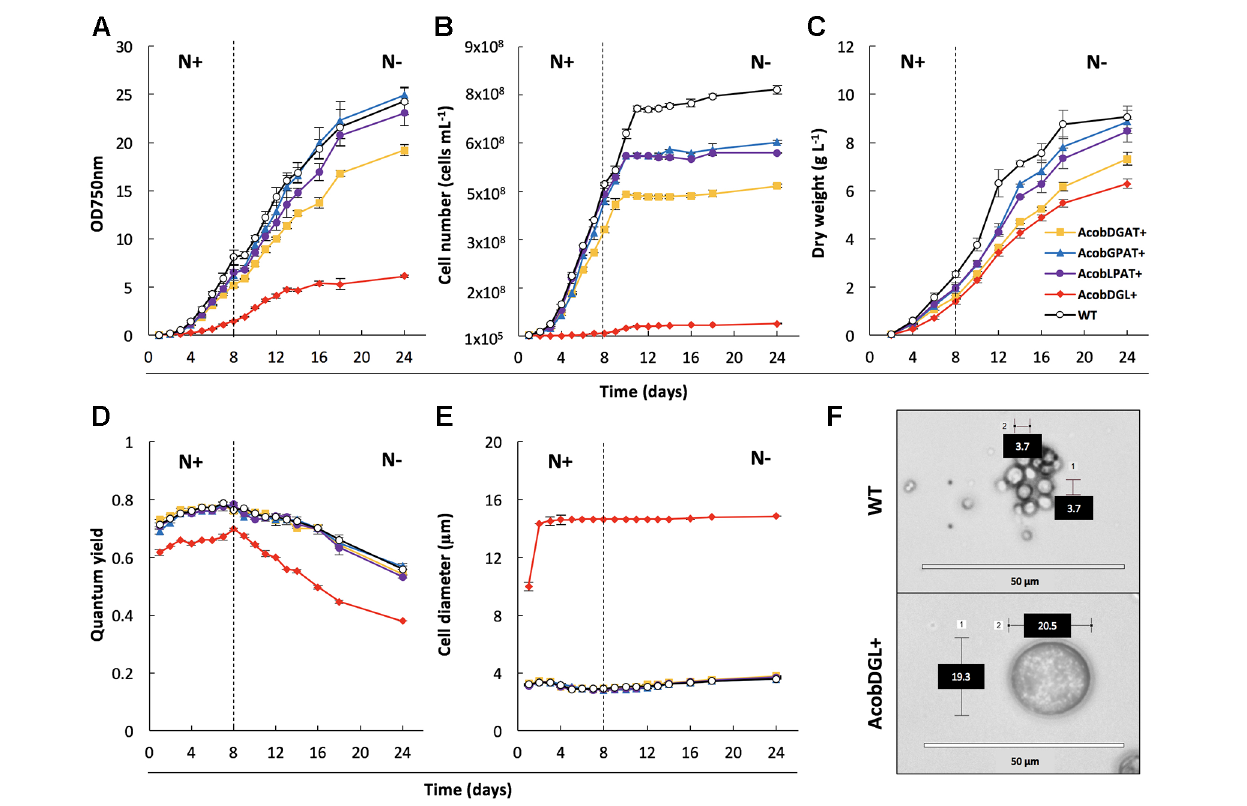
FigUrE 2 | Analysis of cell growth and photosynthetic efficiency. Measurements of optical density at 750 nm (A) , cell number (B) , dry weight (C) , quantum yield (D) and cell diameter (E) in wild type (WT) strain and transformant lines. Microscopic image of wild type strain and N. oleoabundans expressing DGAT , GPAT, and LPAT simultaneously (F) . Dashed lines indicate the moment at which nitrogen starvation started. The data represent the average of n = 3 replicate experiments. Standard deviation bars are